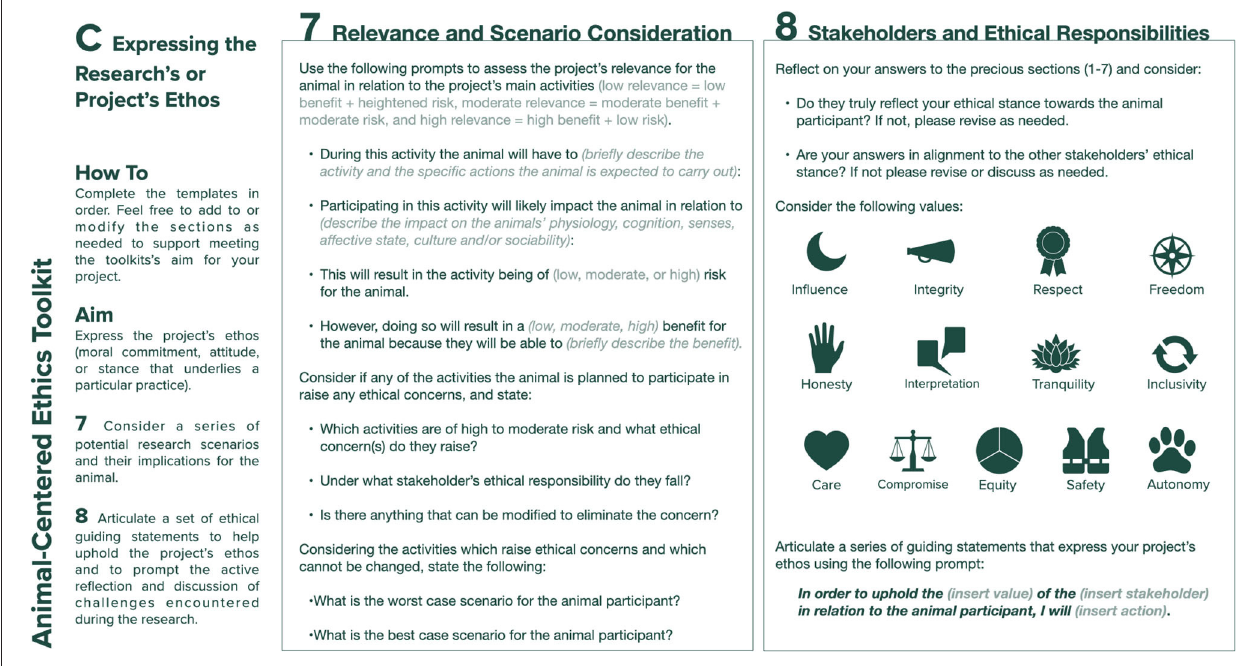
FIGURE 3 | Template C: expressing the project’s